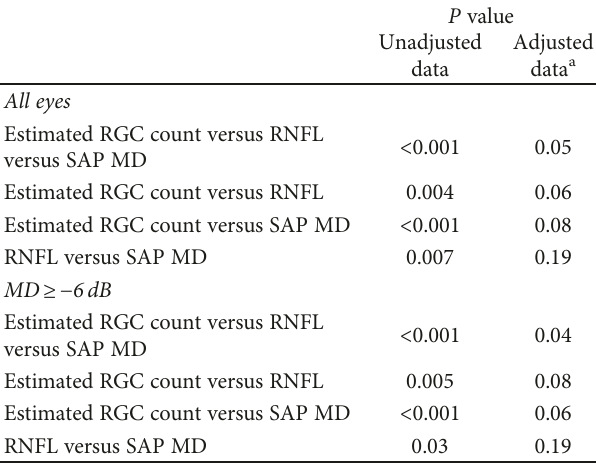
Table 2: Di ff erences between unadjusted data and data adjusted for age and binocularity.